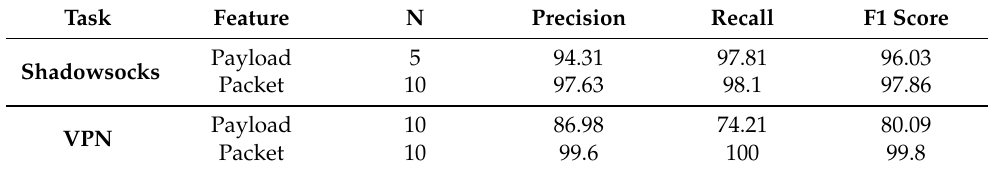
Table 4. The detection performance of the method using the payload size sequence of the flow (%).